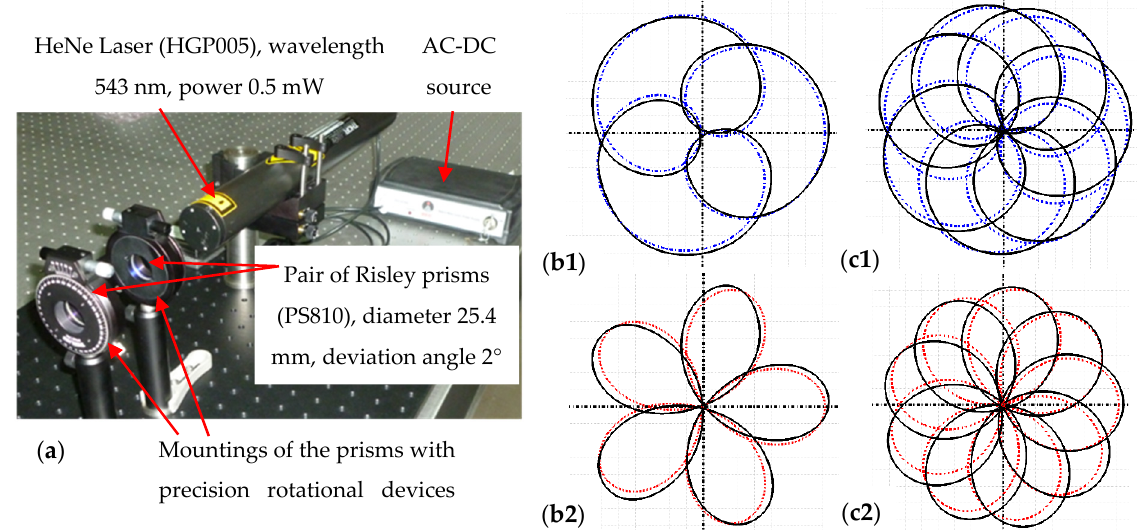
Figure 12. Experimental study of the scan patterns of two rotational Risley prisms: ( a ) setup built with commercially- available Thorlabs components. Superposed, but slightly rotated with regard to each other, simulated (blue and red) and experimental (black) scan patterns, determined for ( b ) | M| = 4 and ( c ) | M| = 8, with ( 1 ) M > 0 and ( 2 ) M < 0.